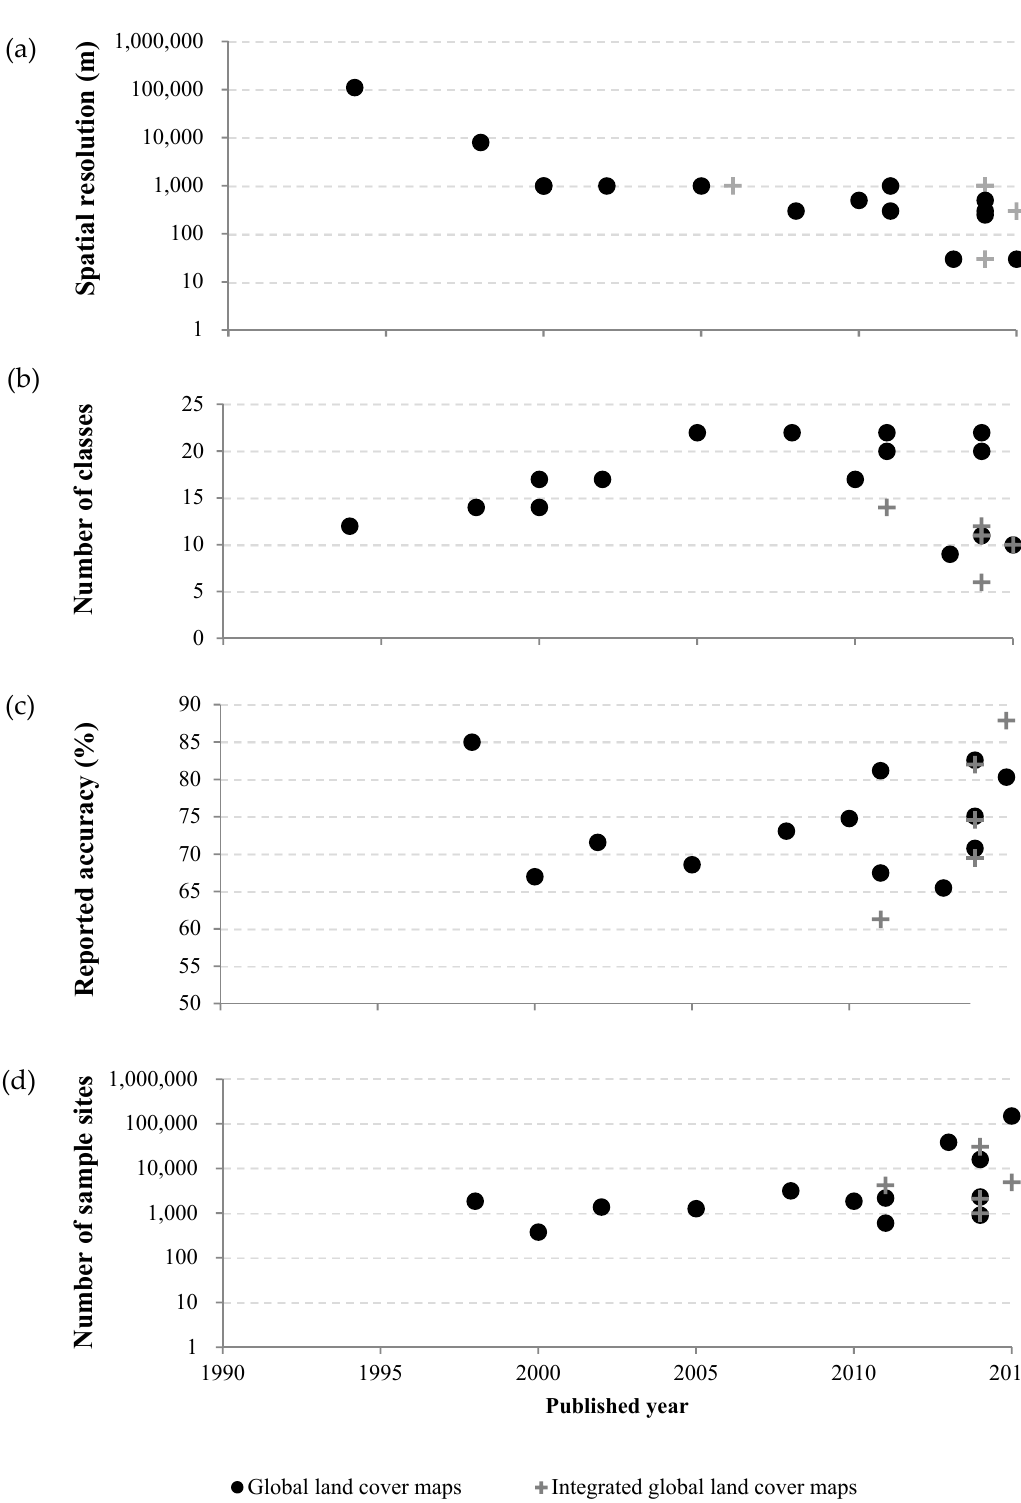
Figure 1. Trends in GLC mapping: ( a ) spatial resolution; ( b ) number of classes; ( c ) accuracy; and ( d ) number of sample sites in the reference database.